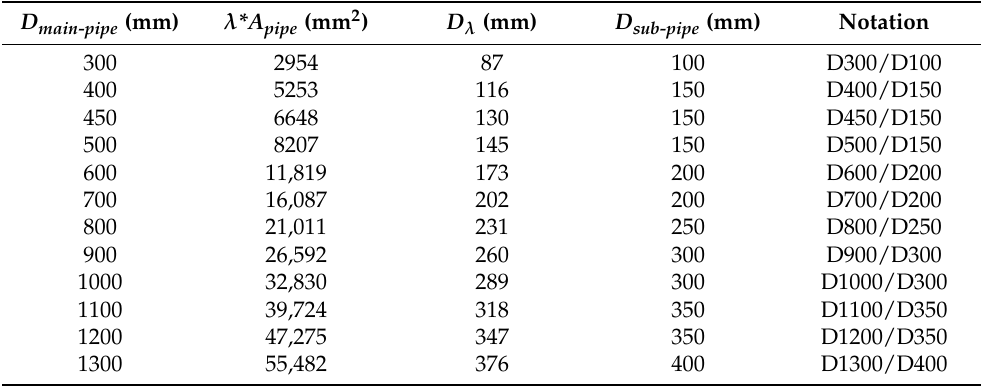
Table 2. Sub-pipe diameter according to main pipe diameter. D main-pipe